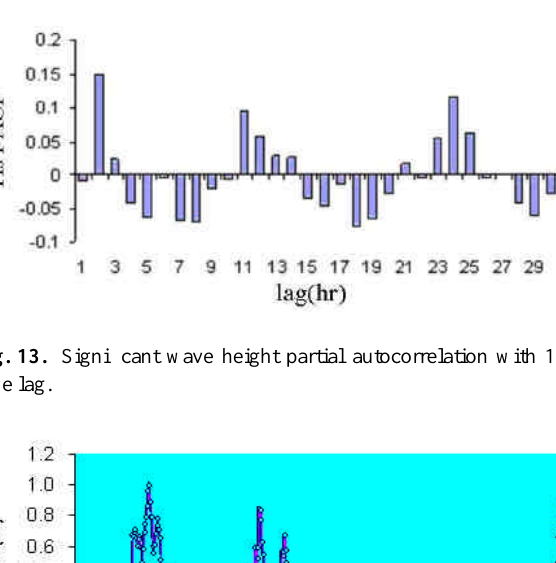
Figure14. Predicted (solid line) and measured (dotted line) significant wave height